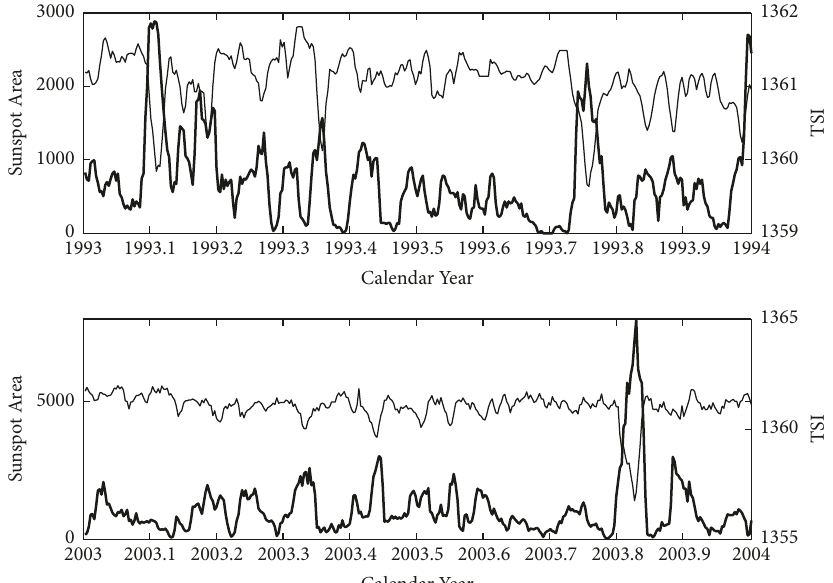
Figure 4: Comparison of TSI (the thin line) and sunspot area (the thick line) in the years 1993 (the top panel) and 2003 (the bottom panel), respectively.